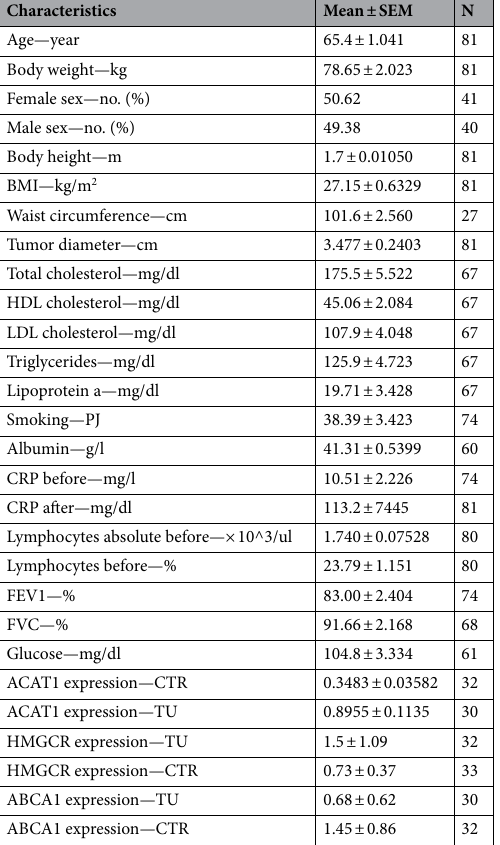
Table 1. Clinical Characteristics of the cohort of patients with NSCLC analyzed in this